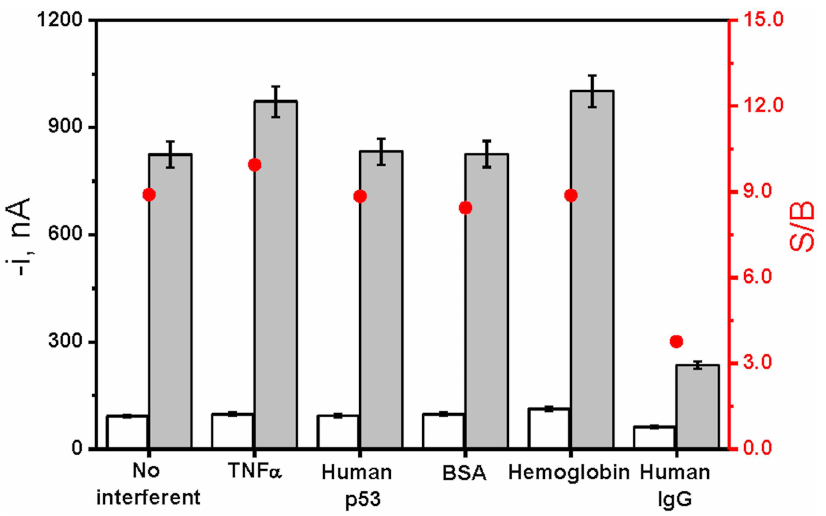
Fig 4. Evaluation of the selectivity of the developed immunosensor for FGFR4. Amperometric signals measuredin the absence(white bars) and in the presenceof 2,500 pg mL -1 FGFR4 (grey bars) and the corresponding S/B ratio ( (cid:15) ) in the absence(1) and in the presenceof 10 ng mL -1 TNF α (2), 200 ng mL -1 humanp53 (3), 5 mg mL -1 BSA (4), 5 mg mL -1 hemoglobin(5) and 1 mg mL -1 humanIgG (6). Error bars estimated as triple of the standarddeviation(n =